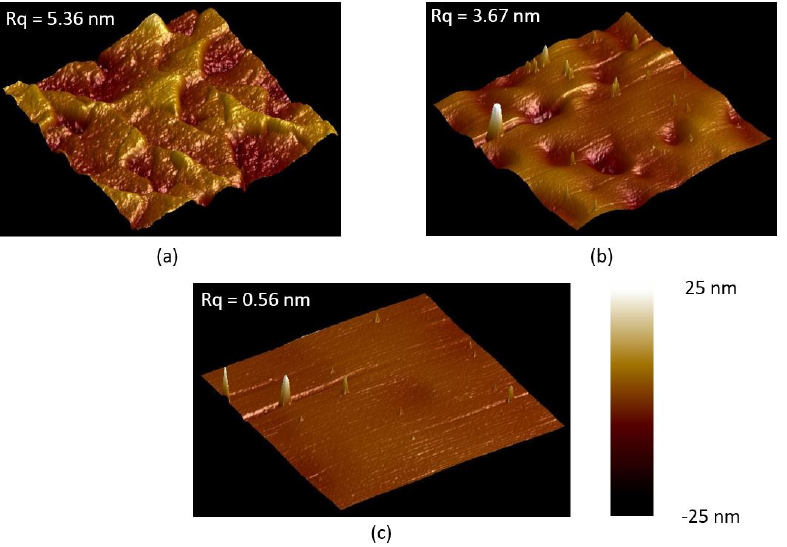
Figure 1. AFM images with 1 µm × 1 µm measurement fields of the 4H-SiC chip surface ( a ) without polishing, ( b ) with mechanical polishing by colloidal silica, and ( c ) with wet-oxidation-assisted